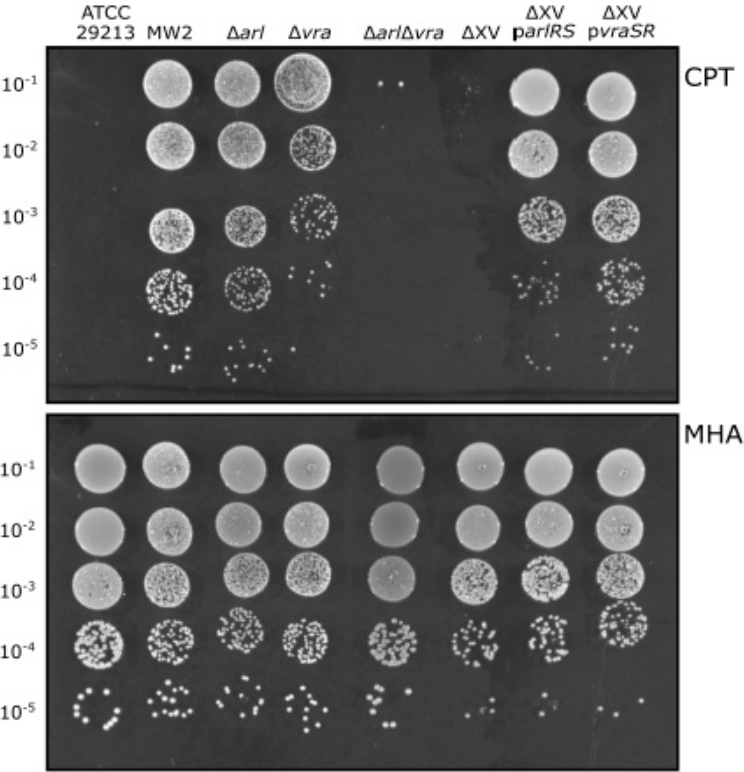
Figure 2. The role of arlRS and vraSR TCS disruption on enhanced ceftaroline susceptibility. Spot plating population analysis profiles (Spot PAP) of MW2 and the corresponding arlRS or/and vraSR - deleted strains together with ∆ XV strain and ∆ XV complemented with either the indicated arlRS - or vraSR -expressing plasmids on MHA plates. ATCC29213 was used as the quality control standard strain. The upper panel corresponds to MHA plates containing 0.25 µ g/mL of ceftaroline (CPT) at 48 h. The lower panel corresponds to MHA control plates without ceftaroline. Spot serial 10-fold dilutions are indicated at the left margin. The first spot (10 µ L) corresponds to 1.5 × 10 5 colony forming units (CFU). Table 1. ECF a on 0.25 µg/mL of ceftaroline-supplemented agar and MIC/MBC.